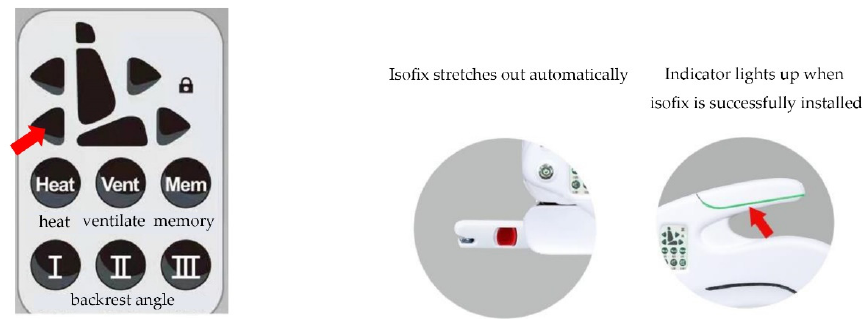
Figure 2. Control Isofix automatic extension with the control panel on the